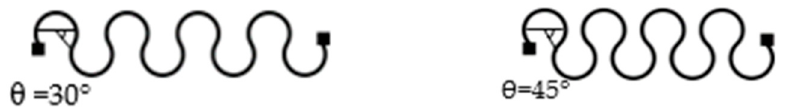
Figure 2. Sinusoidal patterns (not to scale) at various amplitudes, line widths, and cycles created using GIMP software.